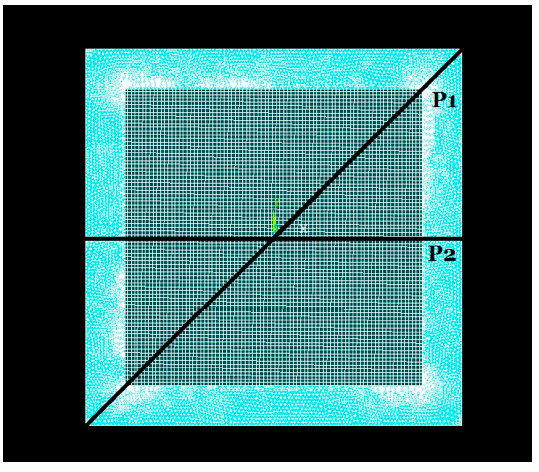
Figure 4. The finite element mesh of the composite diaphragm.